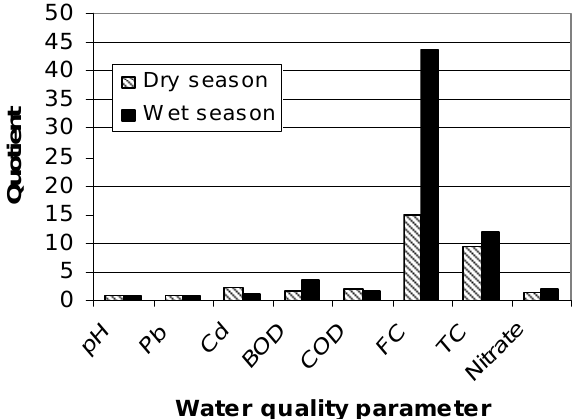
Figure 2 : Quotient factors for water quality parameters in wells near defecation sites relative to the wells in residential area.